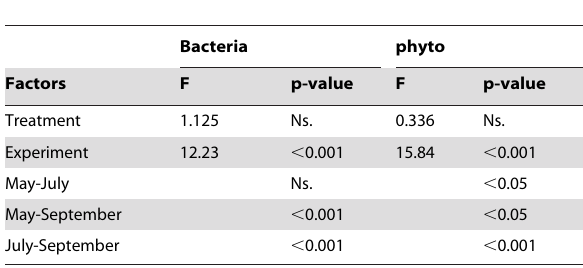
Table 2. Impact of treatment and experiment to betadispersion of bacterial and phytoplankton communities (upper two lines), and pairwise comparisons of betadispersion of experiments (lower three